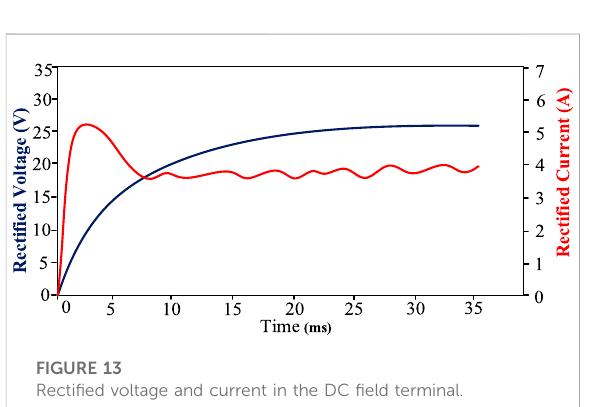
FIGURE 13 Recti fi ed voltage and current in the DC fi eld